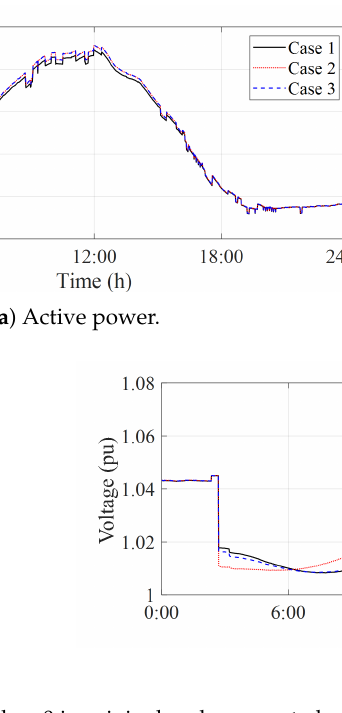
Figure 6. Profiles at bus 0 in original and aggregated models with volt-var control. These are randomly extracted one-day results of all case